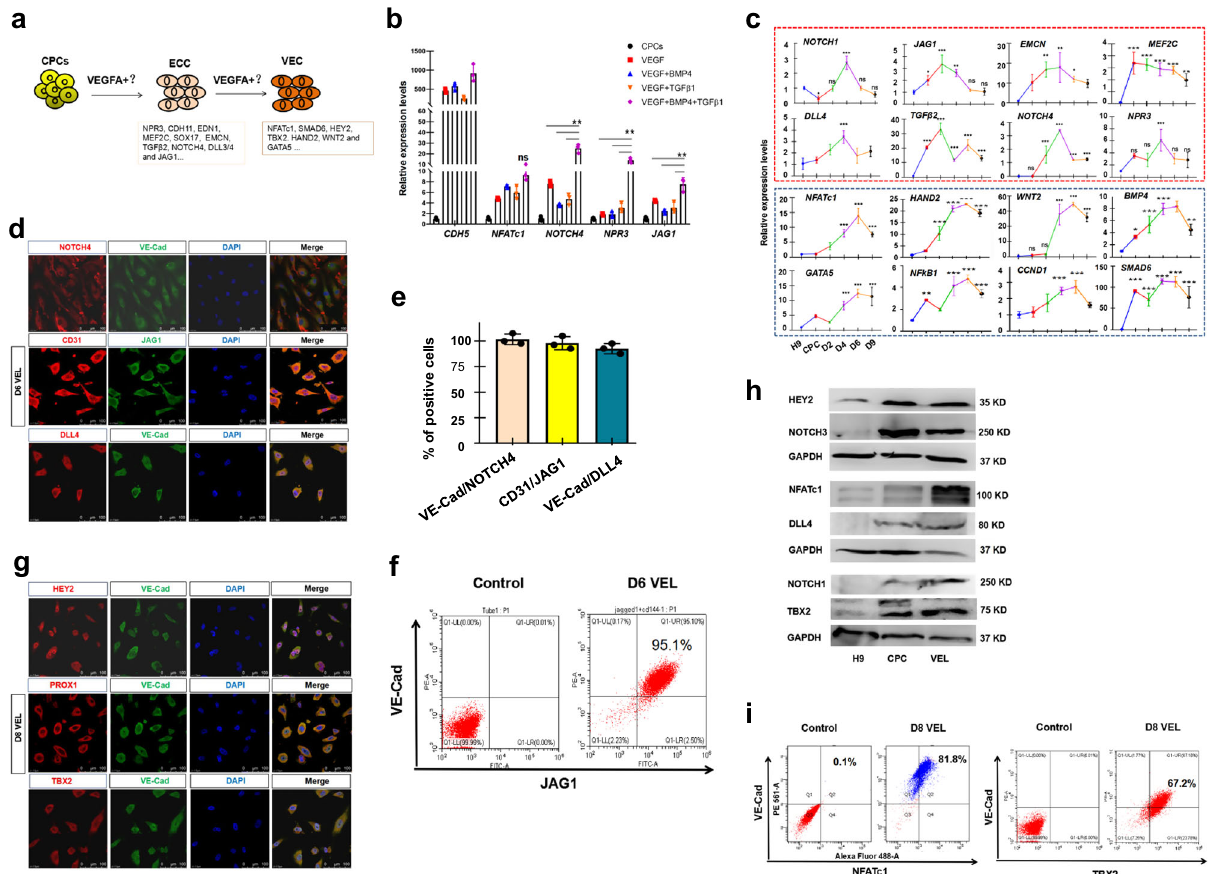
Fig. 2 One step differentiation of CPCs to VELs. a Schematic of differentiation hPSC-derived CPCs to ECC and VEC-like cells. b The qRT-PCR analysis of the selected ECC genes for day 6 hPSC-derived cells. Note that the combined treatment with VEGF, BMP4, and TGFb1 leads to a marked upregulation of ECC genes. c Time-course gene expression analysis of the indicated genes during hPSCs differentiation to CPCs and CPCs to VEC-like cells. The ECC- enriched genes are highlighted by a red dashed box, and the VEC-enriched genes are highlighted by a blue box. d IF staining of day 6 hPSC-derived cells, showing double positive cells for NOTCH4/VE-cad, DLL4/VE-cad and CD31/JAG1, respectively. Scale bar: 25 μ m. e Percentage of NOTCH4/VE-cad-, DLL4/VE-cad- and CD31/JAG1-double-positive cells of ( d ), quanti fi ed by ImageJ. Bar graph represents double positive cells ± S.D of three independent experiments. f Flow cytometry results showing the percentage of JAG1/VE-cad double positive cells. Left: epitope controls; Right: JAG1/VE-cad antibodies. g IF staining of day 8 hPSC-derived VELs, showing double positive cells for HEY2/VE-cad, PROX1/VE-cad and TBX2/VE-cad, respectively. Scale bar: 25 μ m. h WB analysis for hPSC-derived CPCs and day 8 hPSC-derived VELs, with the indicated antibodies. i Flow cytometry results showing the percentage of NFATc1/VE-cad and TBX2/VE-cad double positive cells. The paired t test in Graphpad software was used for the statistical analysis. Signi fi cant levels are: * p < 0.05; ** P < 0.01; *** P < 0.001. Shown are representative data in ( d , g